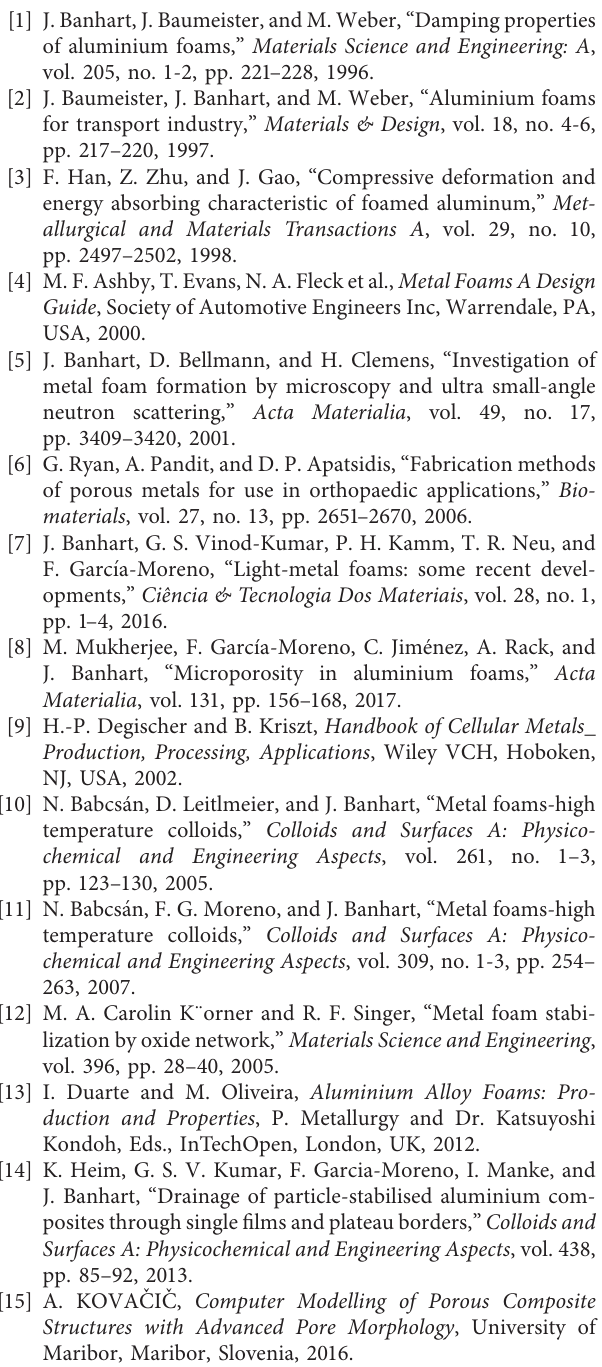
Table 4: Possible mechanisms and their contribution to the volume gain/loss during foaming [23]. Foaming and expansion Influencing factors Gas expansion caused by hydrogen gas produced by TiH 2 decomposition (HP) Volume gain (VG) Gas expansion (GE) corresponded to the temperature rise of the sample ( T s ) Volume loss during the diffusion and overflow process of hydrogen gas (HD) Volume loss (VL) Volume loss during the fracture of surface bubbles